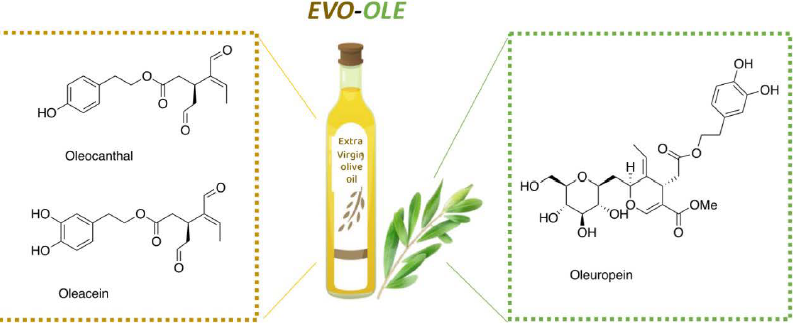
Figure 1. Chemical structures of the principal polyphenols of EVOO and OLE